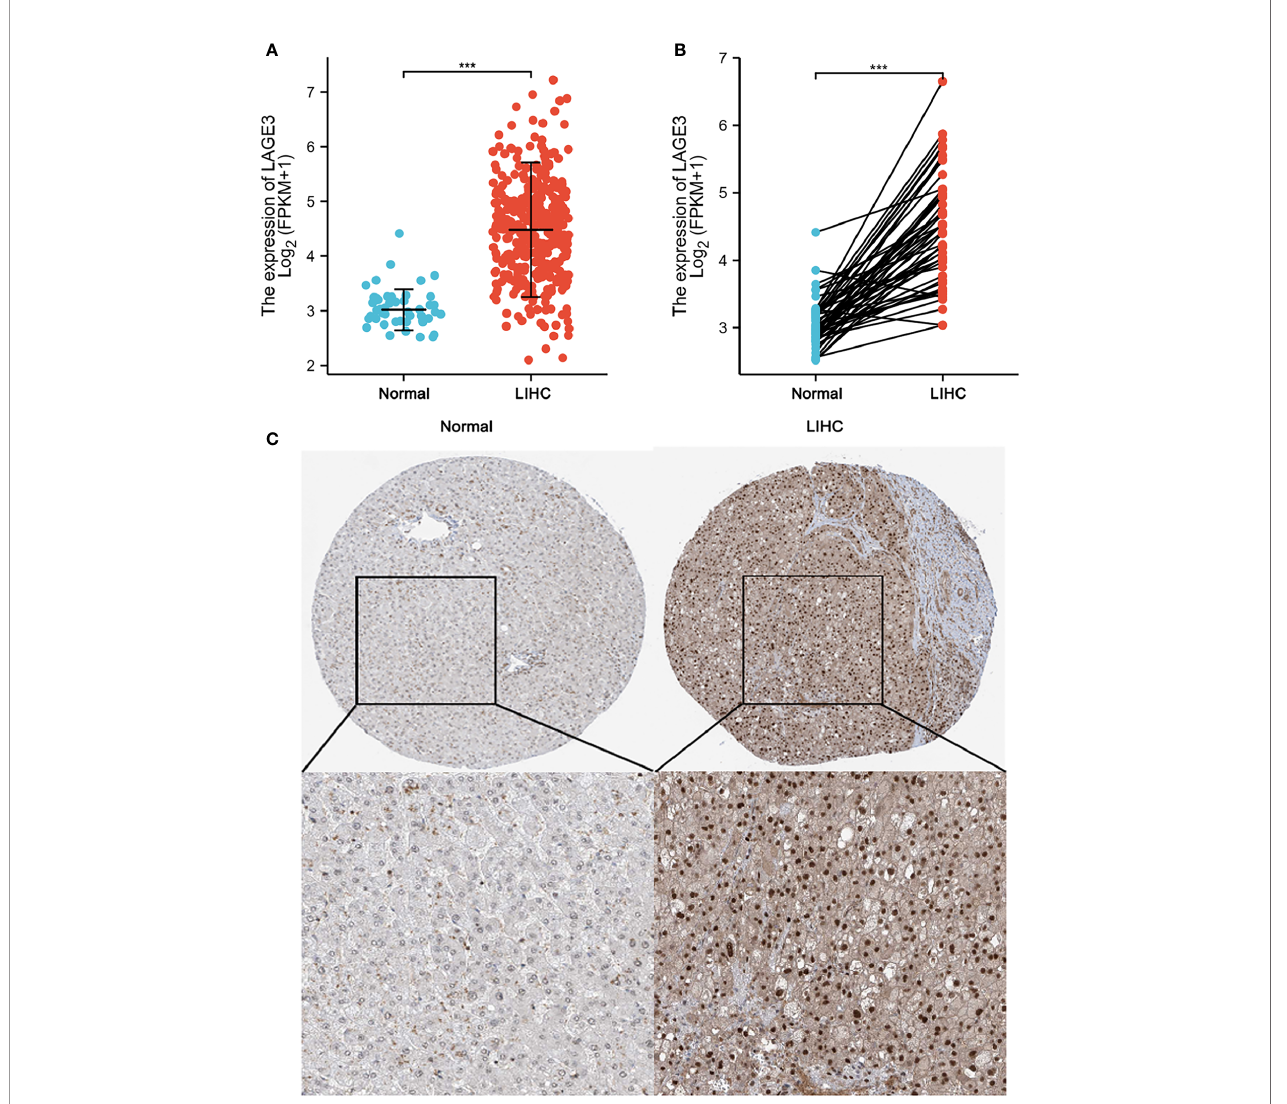
FIGURE 2 | High LAGE3 expression in HCC tissue. (A) The level of LAGE3 mRNA expression in normal and LIHC tissues. (B) The level of LAGE3 mRNA expression in paired tissues. (C) Representative immunohistochemistry images and detailed information of LAGE3 expression in normal liver tissues and HCC tissues from